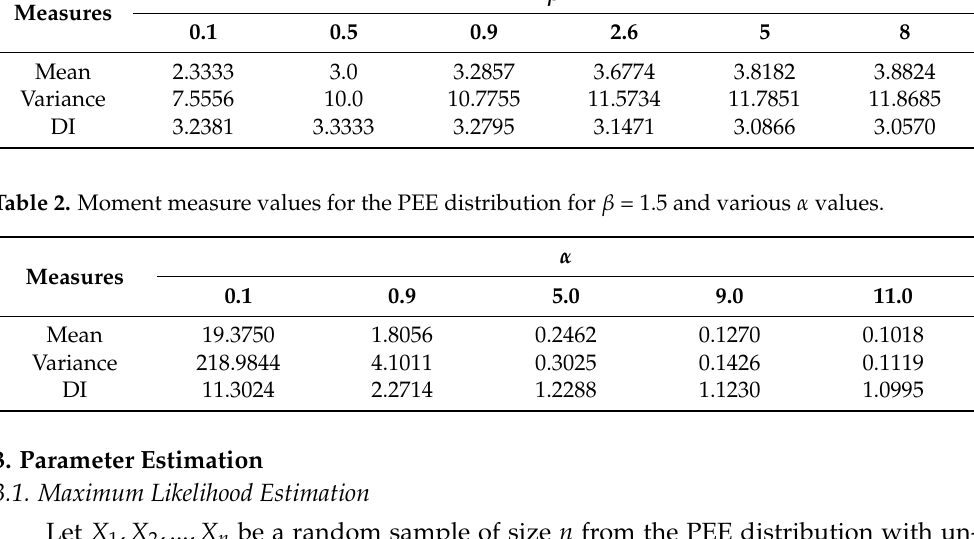
Table 1. Moment measure values for the PEE distribution for α = 0.5 and various β values. Measures